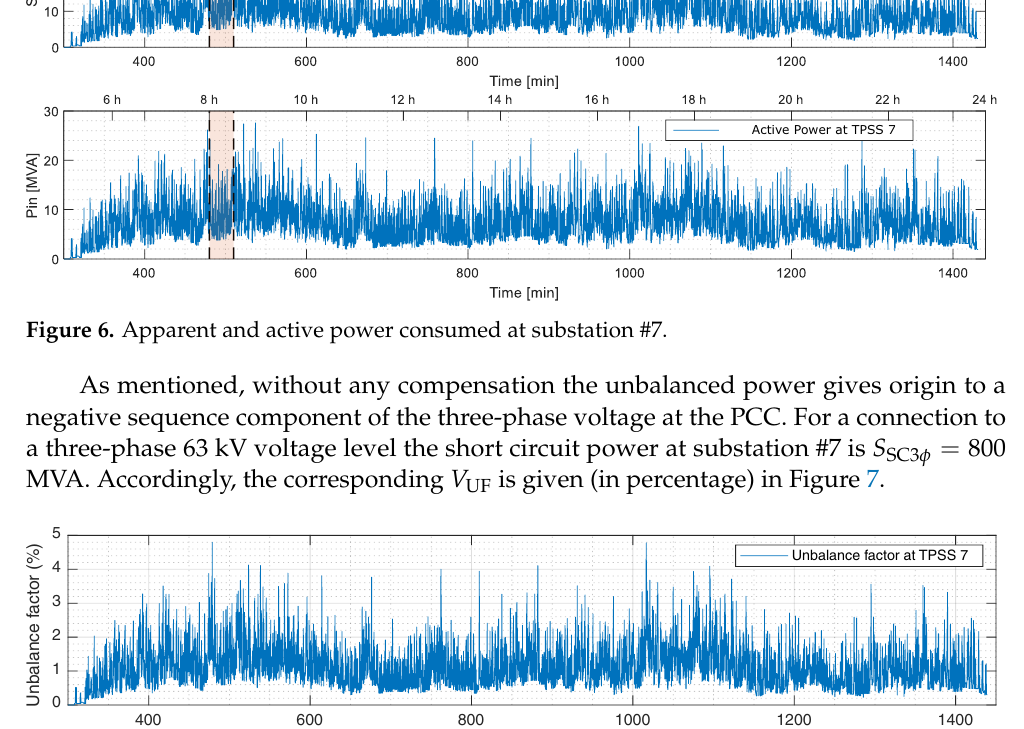
Figure 7. Voltage unbalance factor profile at the PCC corresponding to substation #7. The V UF profile ranges from zero to near 5%. While important, because it indicates that V UF exceeds 1%, this information is not sufficient either for calculating the effective V UF factor that matters for standards fulfilling or for conformity assessment of quality of service agreements. Usually, larger time windows and averaging factors are used to establish the effective value for V UF [30]. An additional illustrative information is obtained with the plots of the histograms of all substations in terms of the equivalent voltage unbalance factor, where it is used the dataset of timestamped measurements for each TPSS power consumption, sampled at one-second for around 19 h (from 05:00 to 24:00). In Figure 8 is shown this plot and it should be pointed out that the short circuit power is different for each